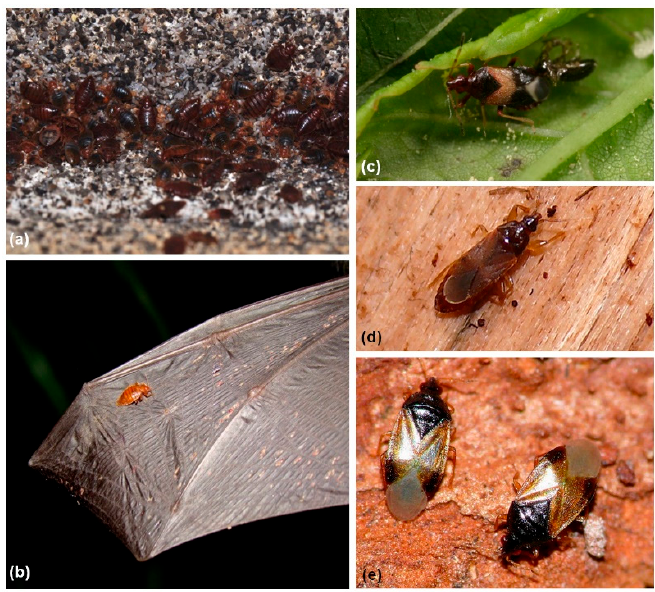
Figure 1. Habitus photographs of cimicoid species. ( a ) Cimex pipistrelli aggregating in a roost in To č ník Castle (Bohemia, Czech Republic) where Myotis myotis (greater mouse-eared bat, Vespertilionidae) dwells; ( b ) C. pipistrelli feeding on Nyctalus noctula ’s wing (common noctule, Vespertilionidae) (Slovakia; photo taken by M. Celuch); ( c ) just-emerged Anthocoris chibi on Artemisia princeps var. orientalis (Korea); ( d ) Lasiochilus japonicus dwelling under the bark of a dead oak tree (Korea); ( e ) Orius minutus during winter hibernation under the bark of Zelkova serrata (Ulmaceae) (Korea).